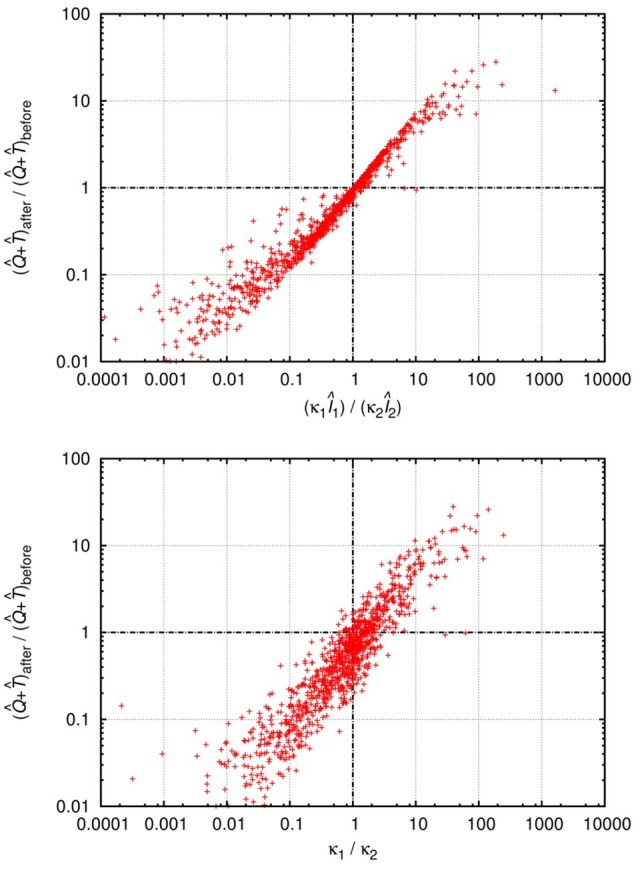
Relative change of the total uninfected target cell count (Q^+T^) after and before successful superinfection, plotted against the total rates of activation (κ1Î1)/(κ2Î2) (top) or the ratio of the activation parameters κ1/κ2 (bottom) of the two virus strains in the HIV-induced activation model. The results of 20,000 simulation runs with successful superinfection are shown. In each run, all parameters were drawn randomly with uniform distribution from the intervals presented in Table A5 (Appendix); the cases with healthy (uninfected) cell counts between 500 and 1,500 per μL were used for the analyses. Both axes are logarithmic.